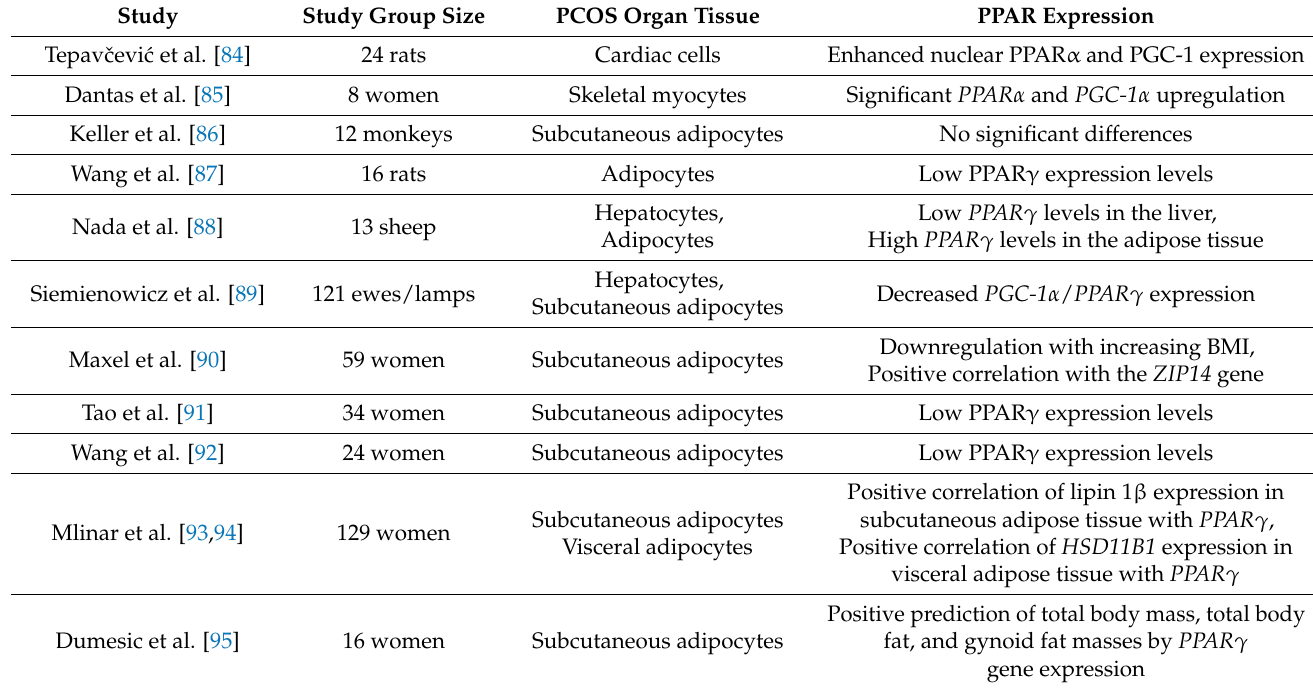
Table 2. PPAR expression in PCOS organ